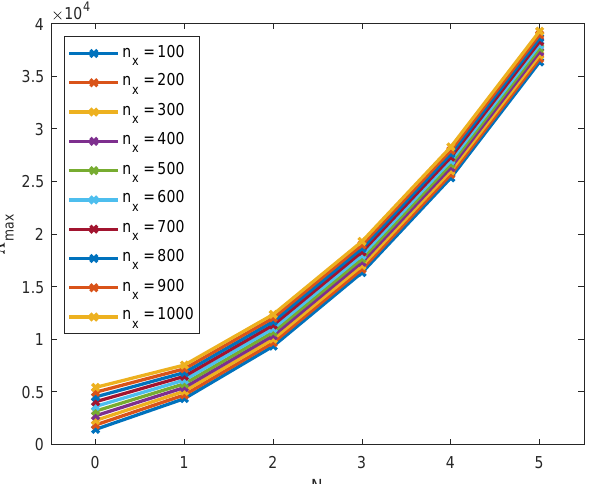
Figure 7. Fastest eigenvalue Λ max for different n x , N and constant λ = 10 − 4 . For the data, see